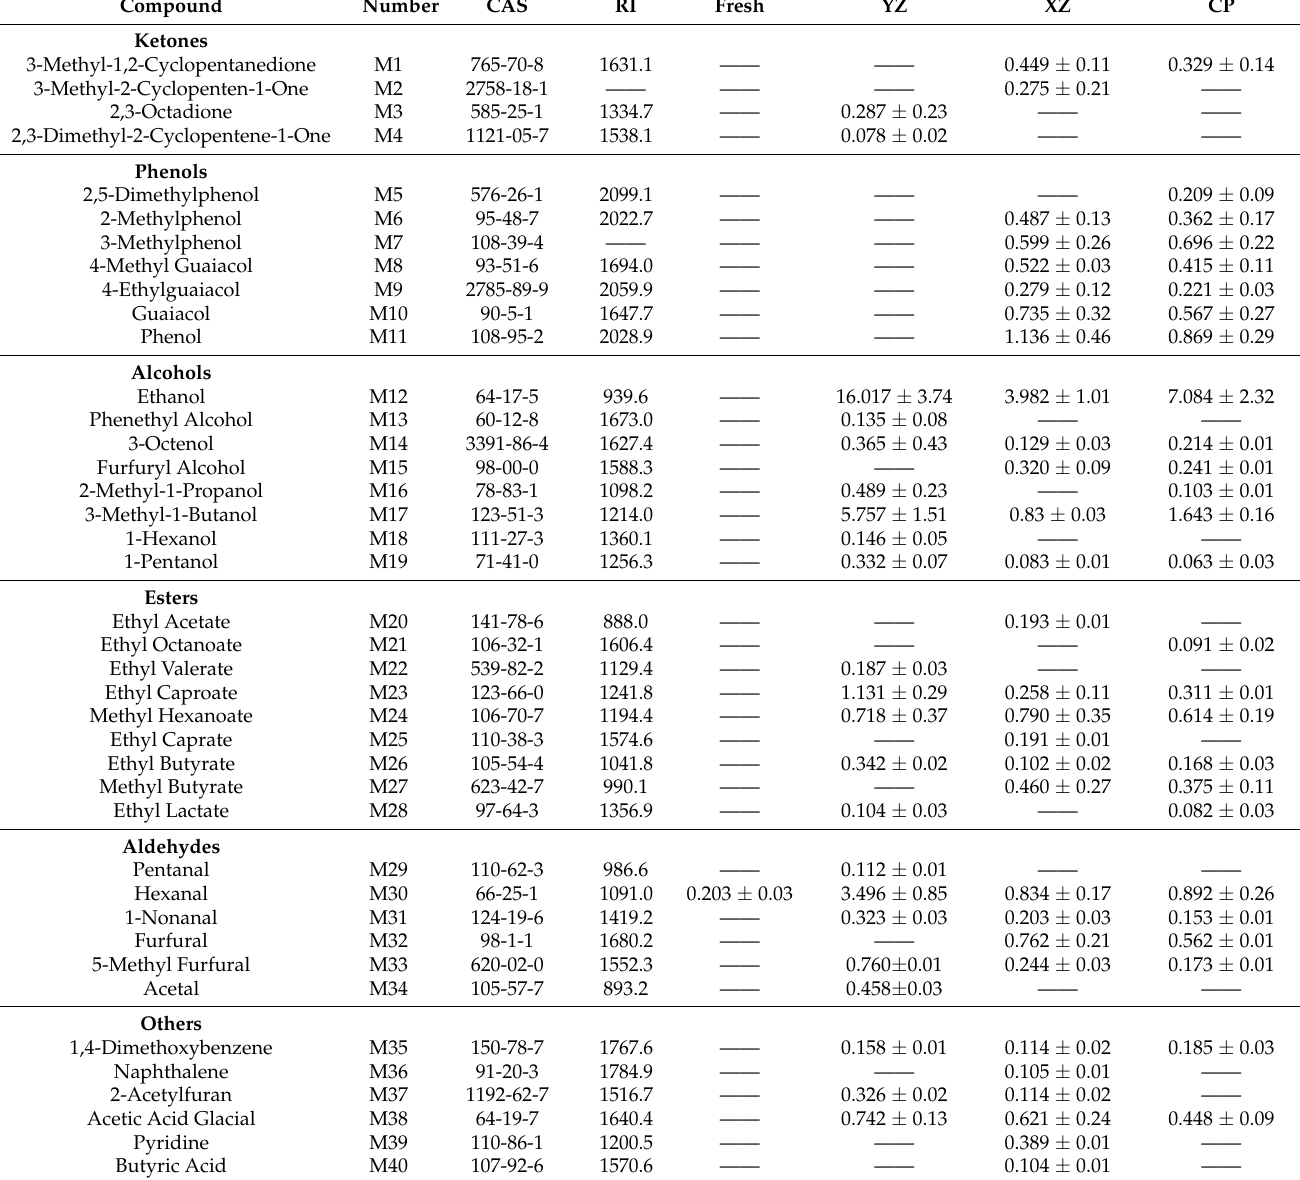
Table 2. Volatile compounds in four stages of Zhenba bacon by GC–MS.